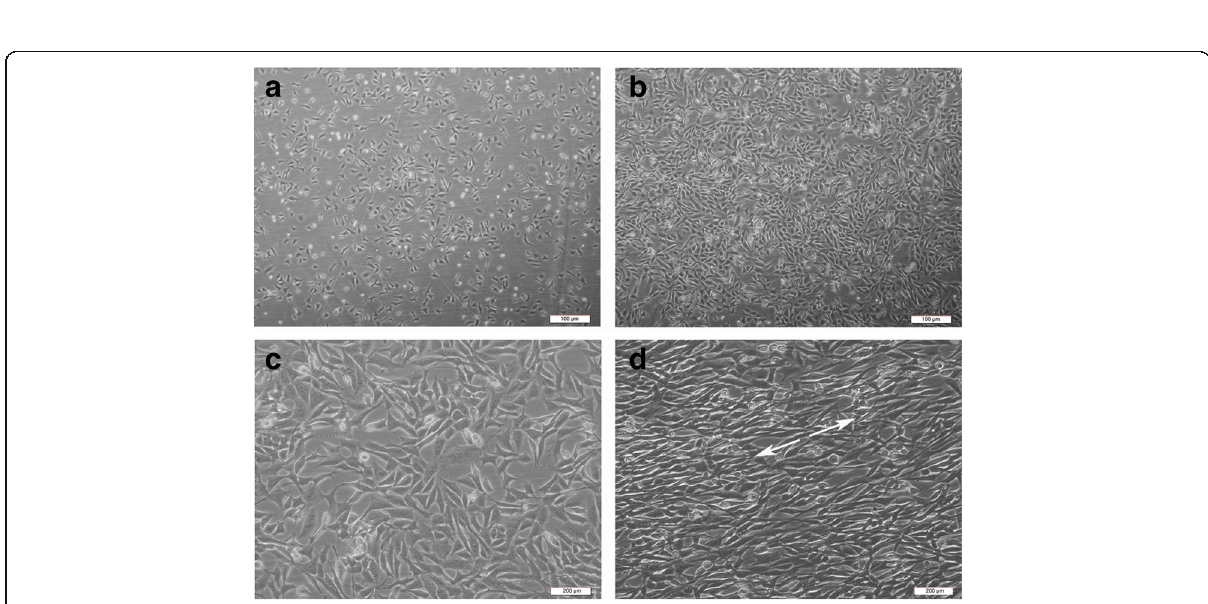
Fig. 5 Mechanical strain changed the morphology of OCCM-30 cells. a - d are representative images of the control group and the mechanical strain-treated group. a Four hours after cells being seeded on the plate. b Cells that grew for 48 h in the incubator, before the mechanical strain application. Scale bars: 100 μ m. c The control group that was placed in the bending boxes but did not accept any mechanical strain. d The morphological image taken after 18 h mechanical strain. As shown in the representive images, the application of mechanical strain resulted in a tendency of cell realignment corresponding to the direction of the mechanical strain. The arrows decipher the direction of mechanical strain. Scale bars: 200 μ